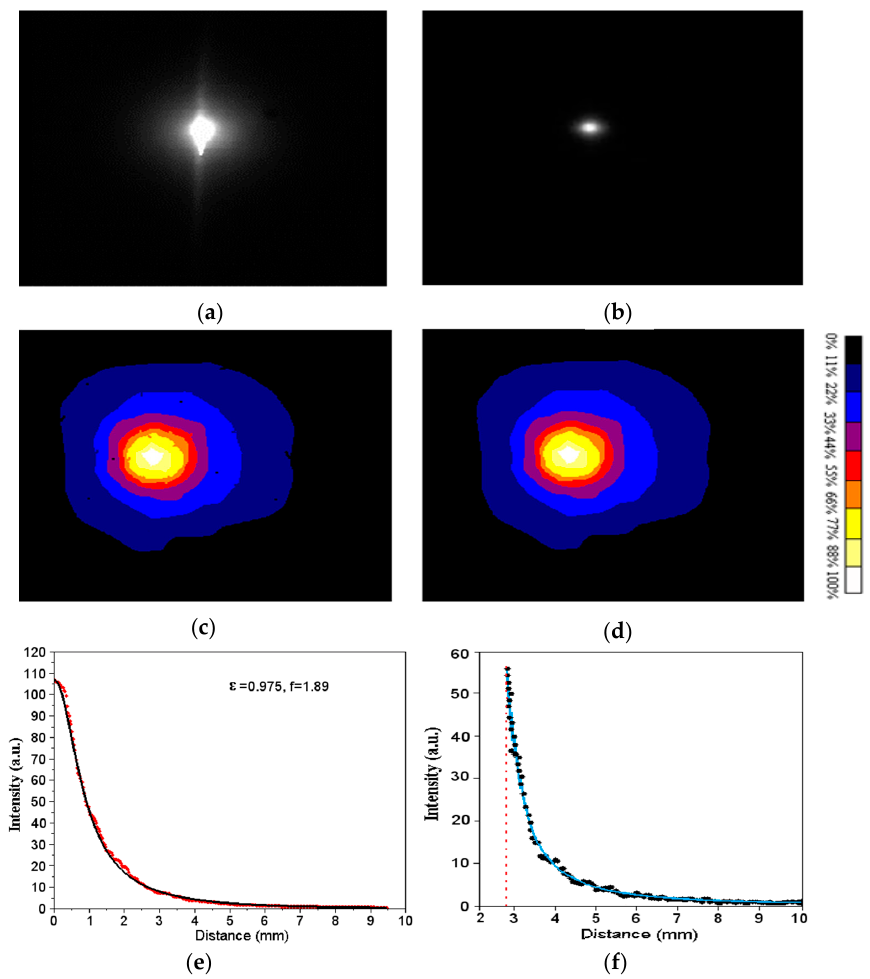
Figure 2. ( a ) Original image captured from Golden Delicious irradiated at the wavelength of 852 nm; ( b ) specular light removed; ( c ) RGB color image; ( d ) processed image; ( e ) fits of the average profiles as calculated from image ( d ) with Equation (2); and ( f ) typical curve fitting using Equation (3).